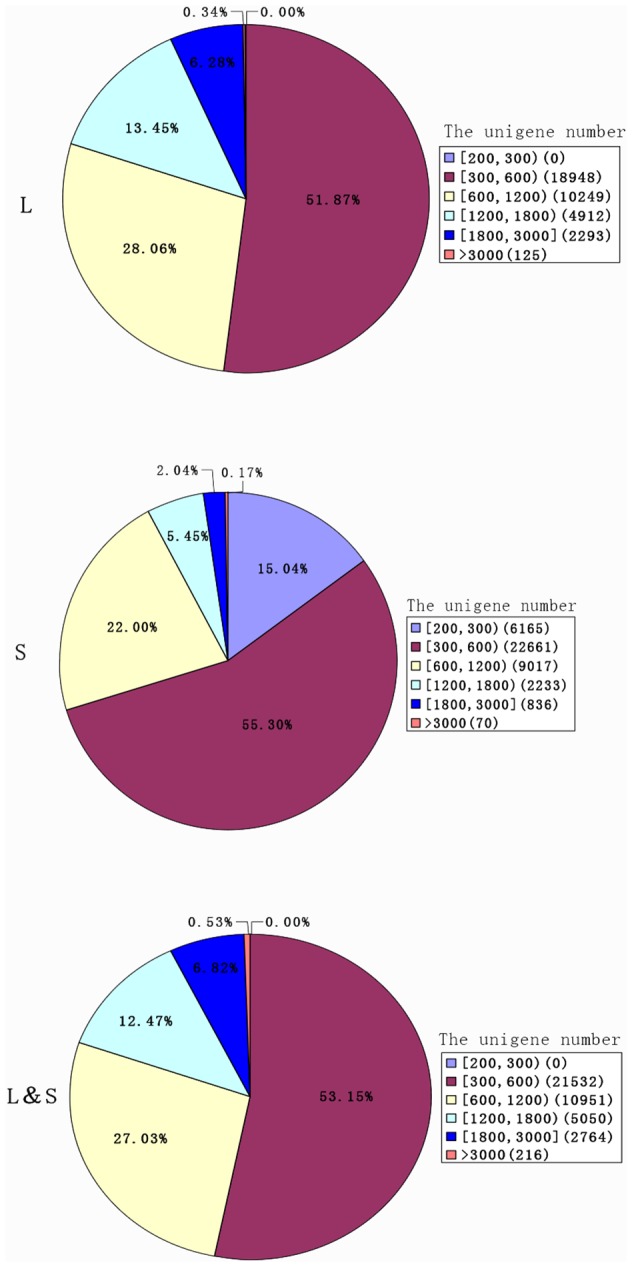
Length distribution of unigenes after de novo assembly using the reads from S, L and S&L libraries.Numbers in square brackets (e.g., [200, 300] and [1800, 3000]) indicate the range of unigene length, ‘>3000’indicates unigenes longer than 3,000 bp. Numbers in parentheses (e.g., (6, 165) and (22, 661)) indicate the total number of unigenes falling in this length range.